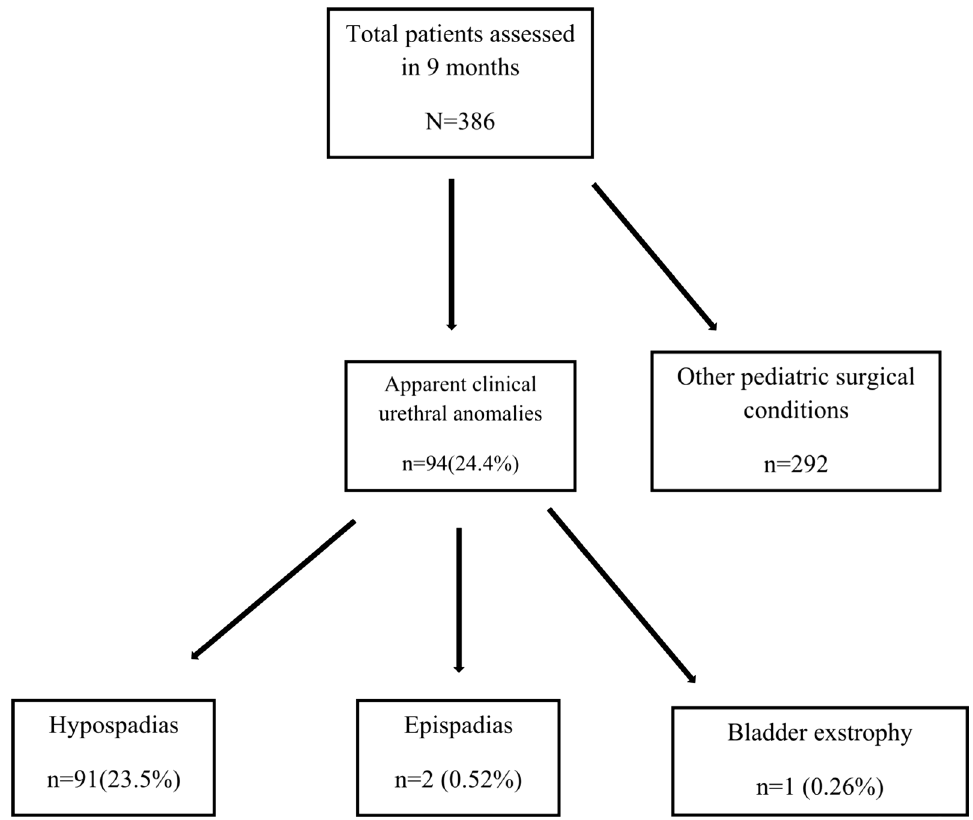
Fig. 1 Proportion of clinically apparent congenital urethra anomalies among patients admitted to pediatric surgery unit